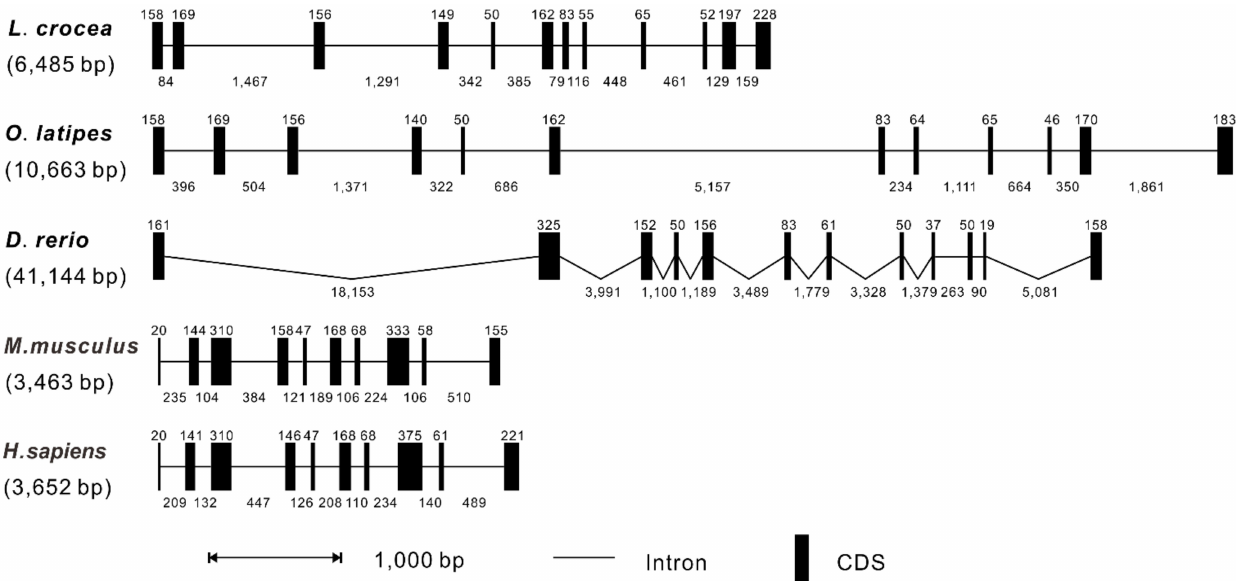
Figure 3. Genomic organization comparison of Lc - RIP3 with other vertebrates. The genomic organization of the Lc - RIP3 gene from various vertebrate species was compared and analyzed including O. latipes , D. rerio , M. musculus , and H. sapiens . Black boxes indicate the coding sequences (CDS) with the length of exons in base pairs (bp) shown above the black boxes. The lines denote the introns with the lengths of the introns in bp shown below the lines. The genomic DNA sequence locations and their accession numbers were obtained from the GenBank database: L. crocea ,